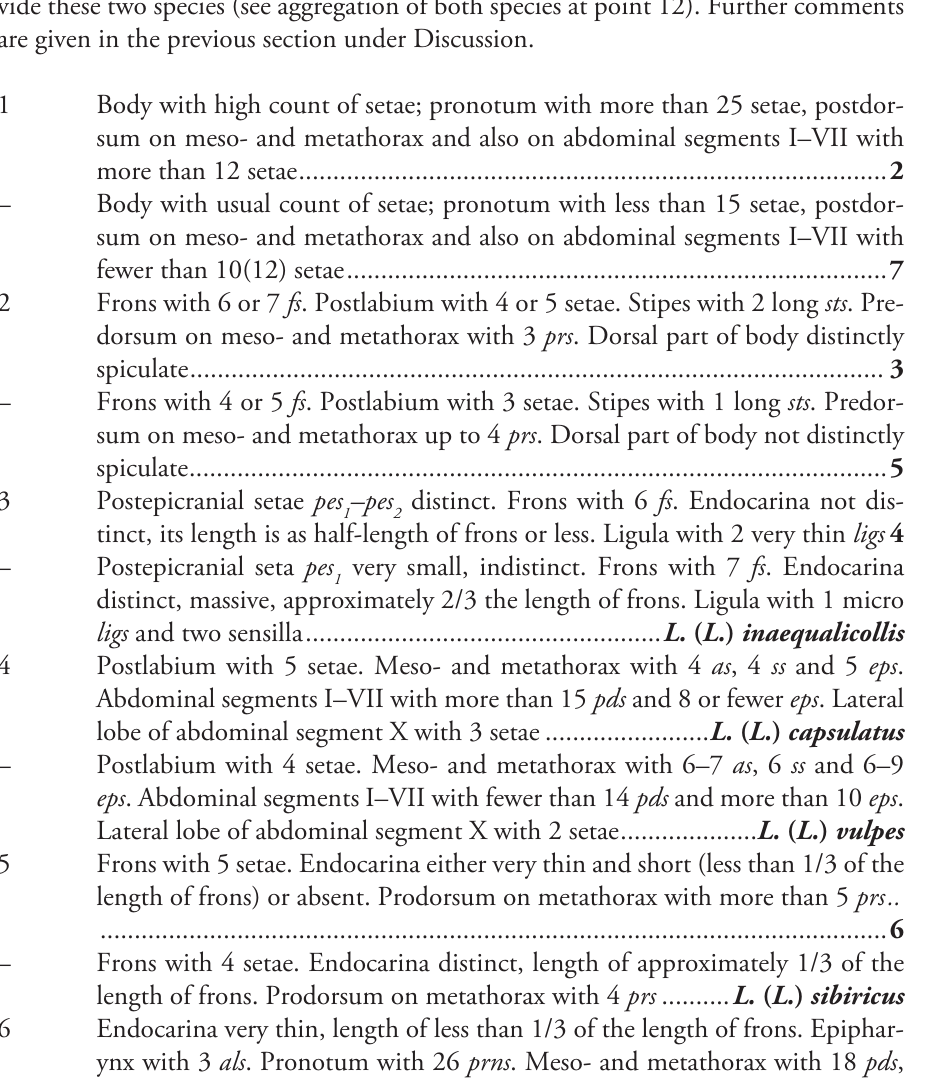
Endocarina very thin, length of less than 1/3 of the length of frons. Epiphar- ynx with 3 als . Pronotum with 26 prns . Meso- and metathorax with 18 pds